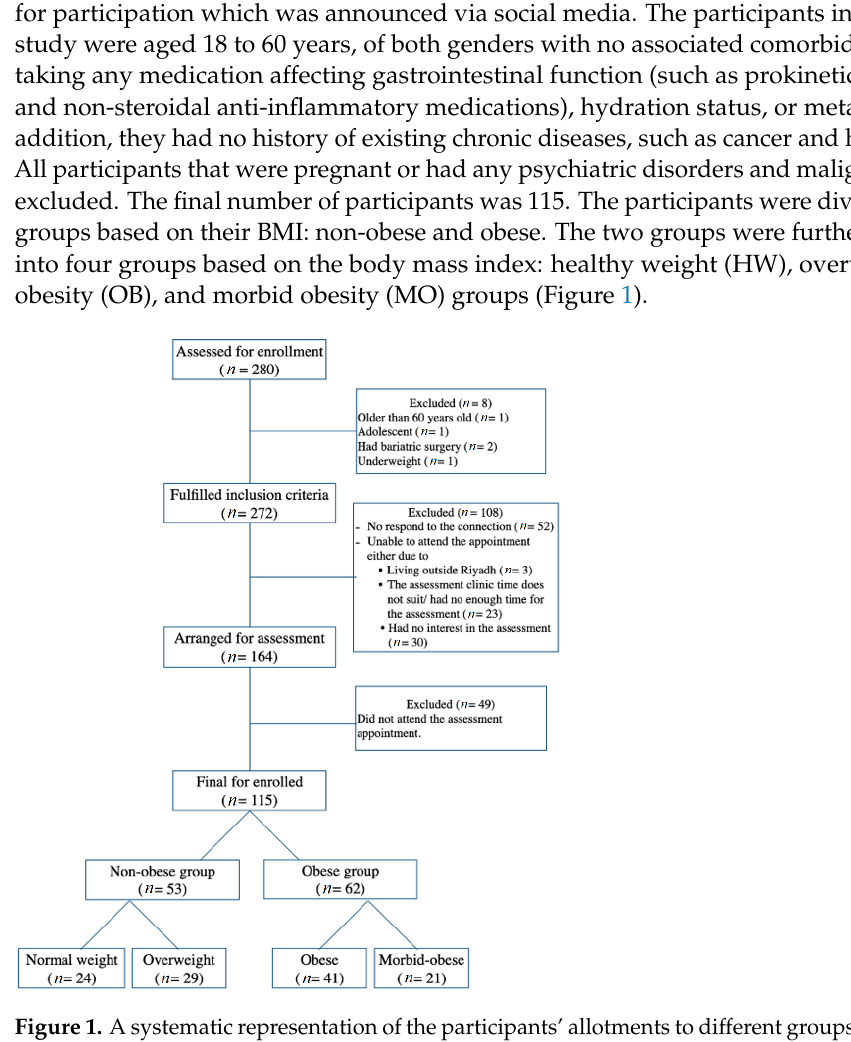
Figure 1. A systematic representation of the participants’ allotments to different groups based on BMI.